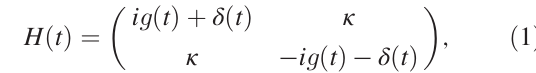
Þ =a ð t Þj as end end ffiffiffiffiffiffiffiffiffiffiffiffiffiffiffi p ρ 2 þ 2 ρ as a